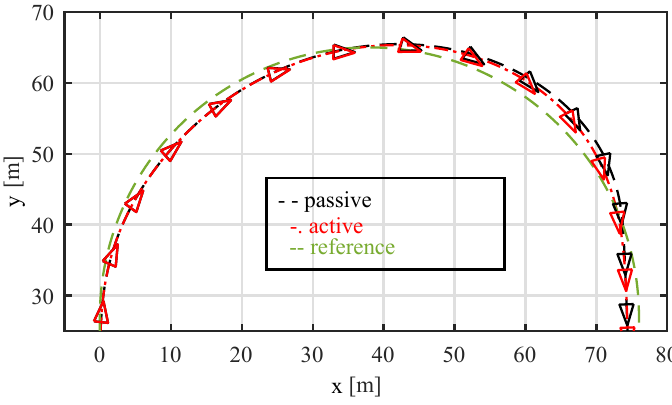
Figure 9. U-turn, highly skilled driver, vehicle cog trajectory. Triangles represent the orientation of vehicle x -axis starting from the vehicle cog.